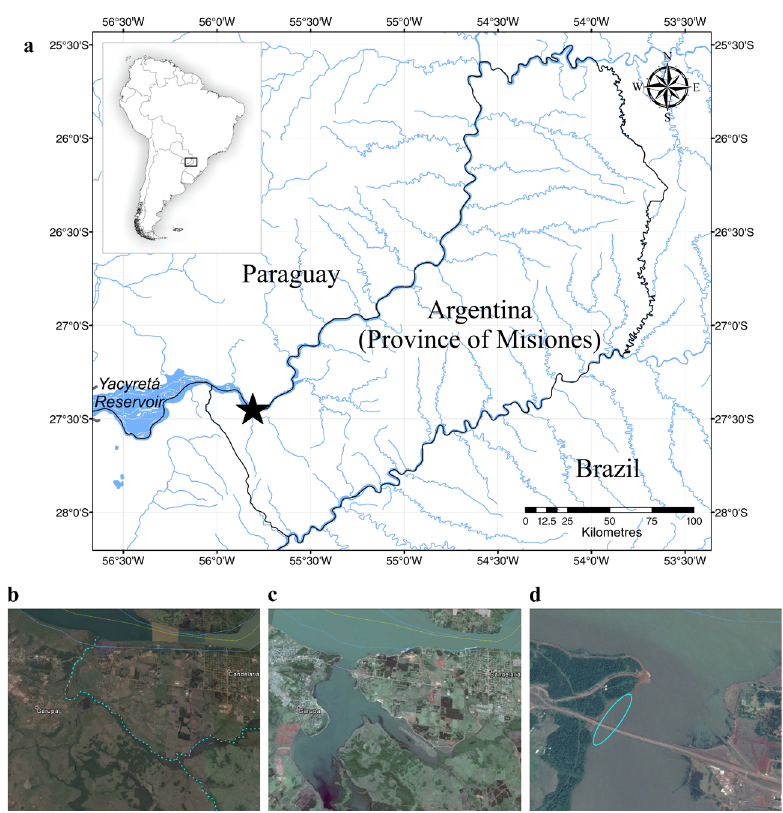
Figure 1. Location of the Garupá Stream and the sampling area. ( a) The star indicates the location of the Garupá Stream in the province of Misiones. ( b ) and ( c ) Satellite images of the Garupá Stream in years 2008 and 2015, respectively; the dotted line in b indicates the course of the stream. ( d ) Satellite image of the mouth of the Garupá Stream in 2016; The oval indicates the zone sampling zone. Satellite images were taken from Google Earth (Version